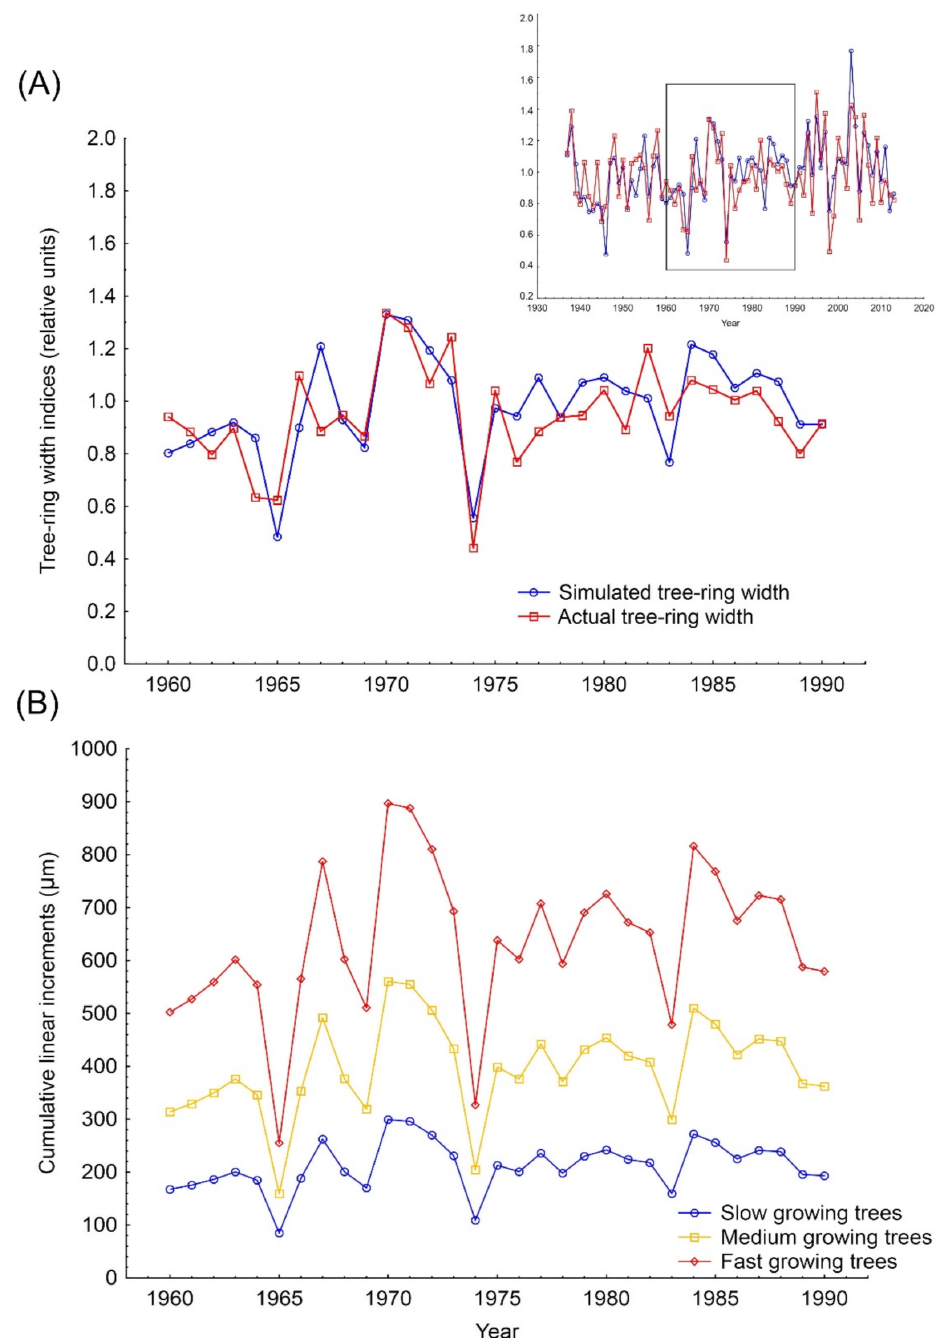
Figure 7. Initial tree-ring width indices (red curve) and simulated tree growth (blue curve) over 1960 − 1990 ( A ); simulated absolute values of cumulative linear increments for slow- (blue curve), medium- (yellow curve) and fast-growing trees (red curve) using the cambial band model for the years 1960 − 1990 ( B